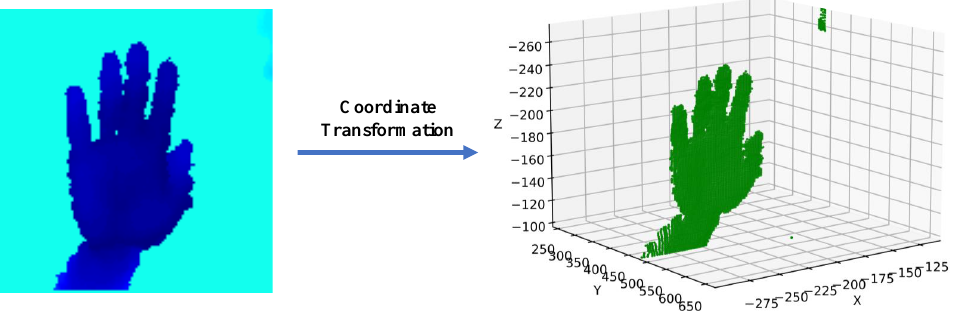
Figure 1. Left : a colorized depth image of a hand. Each pixel on the depth image has its position in the image coordinate frame, which is determined by the row and column in which the pixel is located, and the depth value from the camera. Right : the positions of all the points corresponding to the pixels on the depth image in the 3D world coordinate frame centered at the depth camera. The coordinates of pixels in the two coordinate frames can be converted to each other by coordinate transformation. In the following sections, we use pixels to refer to points in 3D